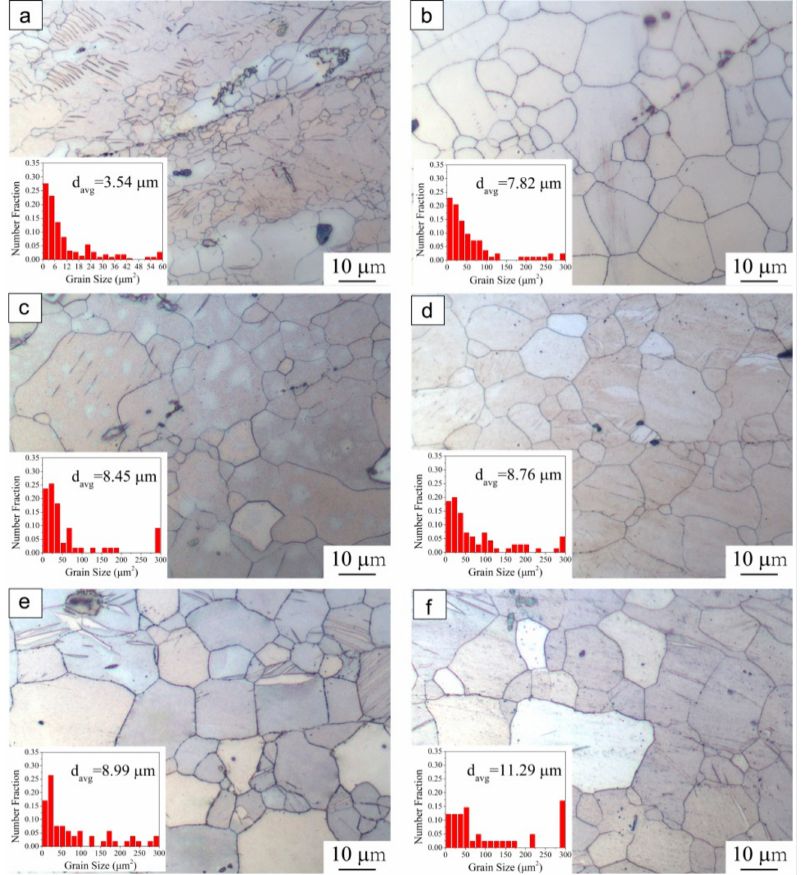
Figure 3. Grain size distributions of compressed specimens (350 ◦ C, ε = 0.6), followed by post-heating treatment at 400 ◦ C with different holding time: ( a ) without holding, ( b ) 1 h, ( c ) 2 h, ( d ) 4 h, ( e ) 8 h, ( f ) 12